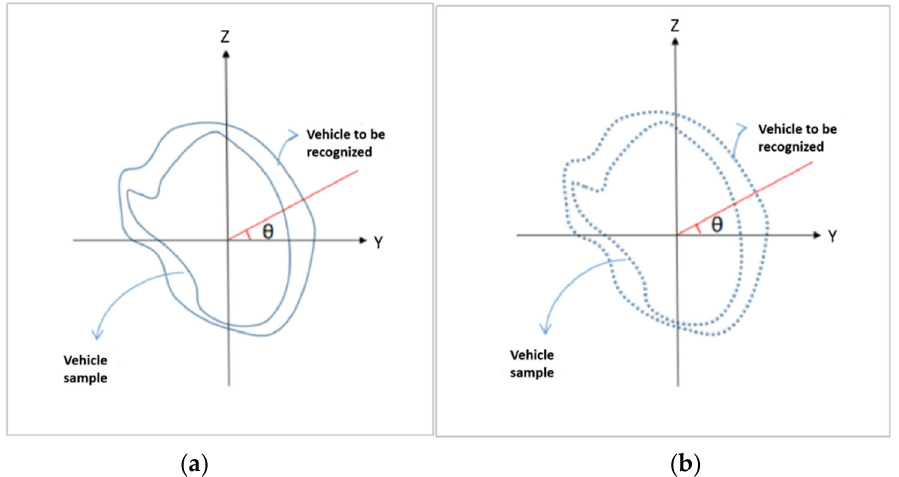
Figure 7. Re-sampling the side projection profile of the point clouds to be recognized. Note: before re-sampling ( a ); after re-sampling ( b ).